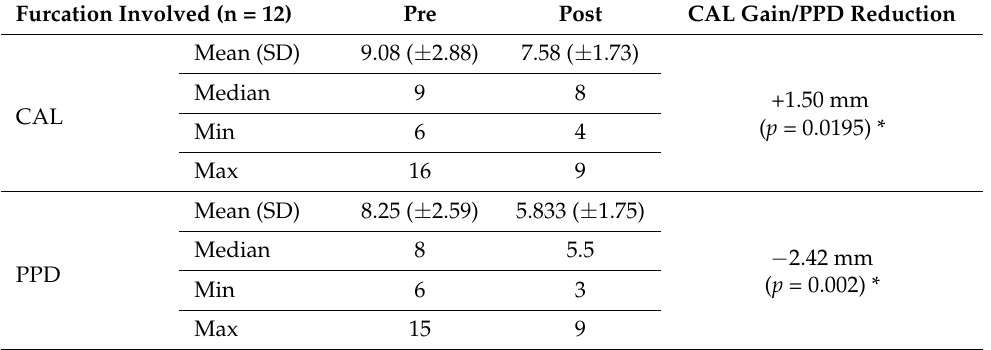
Table 2. Descriptive statistics of PPD and CAL development in furcation-involved sites after com- bined chloramine and xHya treatment. Pre = baseline, Post = 6 months post treatment, * = Wilcoxon signed-rank